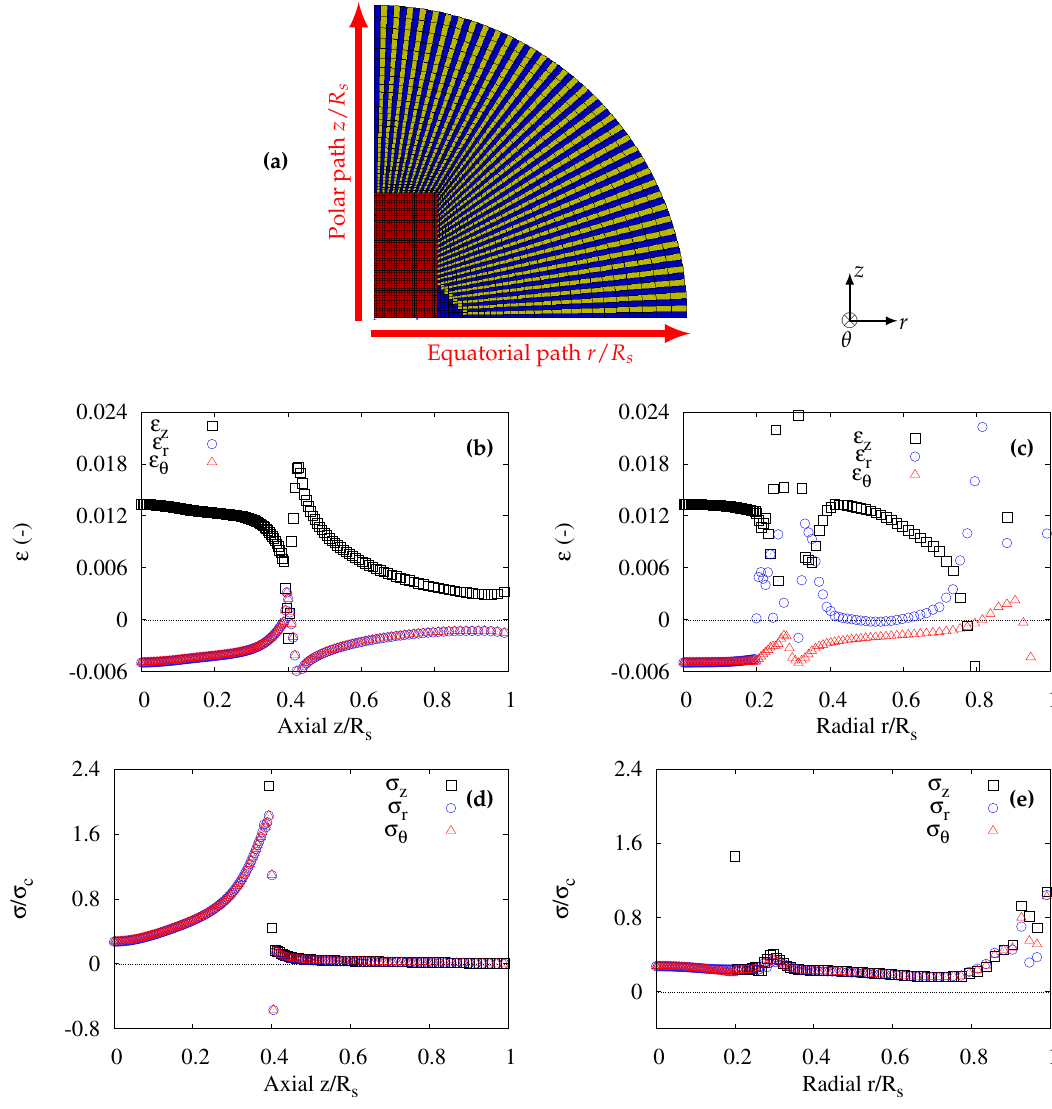
Figure 4. Modelling of spherulite with amorphous-crystalline lamellae: ( a ) mesh and coordinates; ( b ) strains along the axial path; ( c ) strains along the radial path; ( d ) stresses along the axial path; ( e ) stresses along the radial